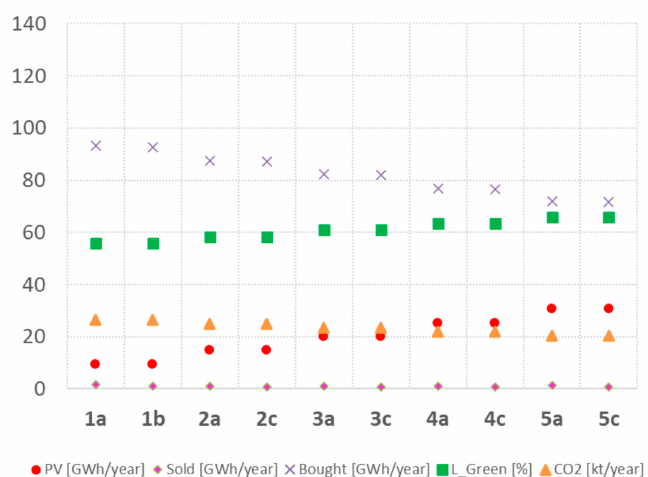
Figure 4. Key performance indicators when no new wind turbines are installed.